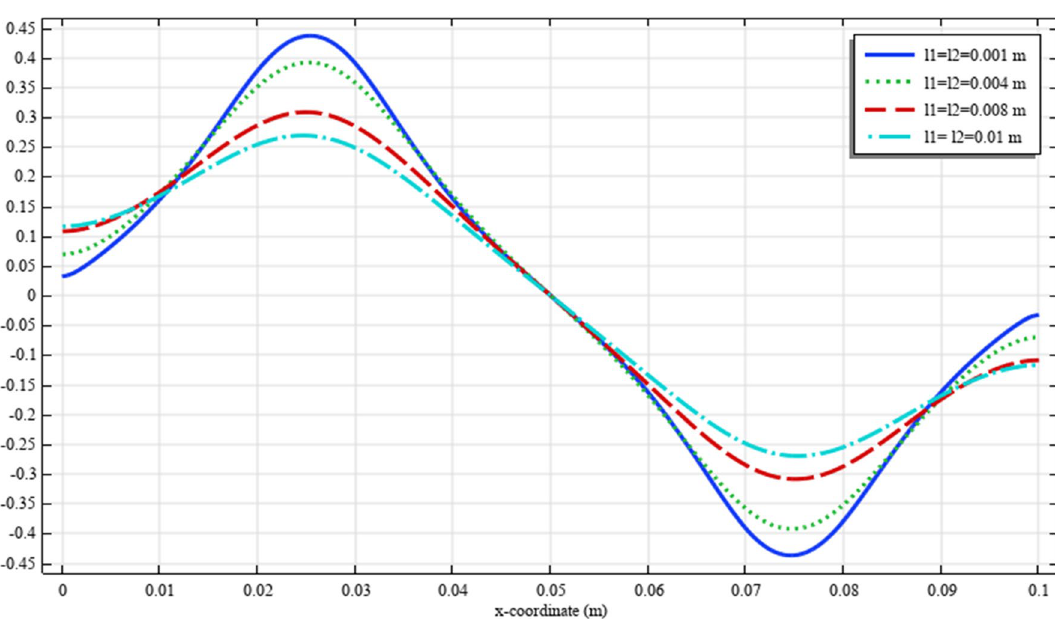
Figure 22. The micro-strain s xy ( x , b / 2 )/ s 0 for different values of ℓ 1 and ℓ 2 (COMSOL